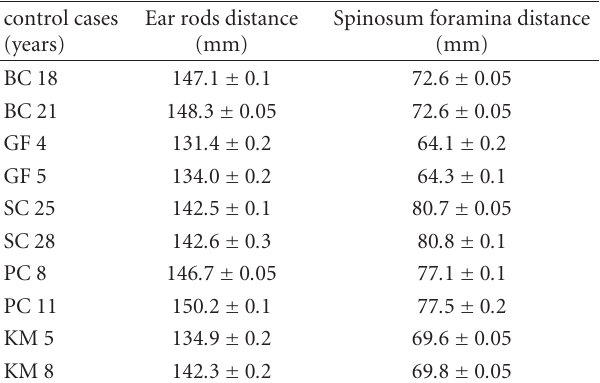
Table 3: Scheme of the distances between the ear rods and the spinosum foramina for the five control